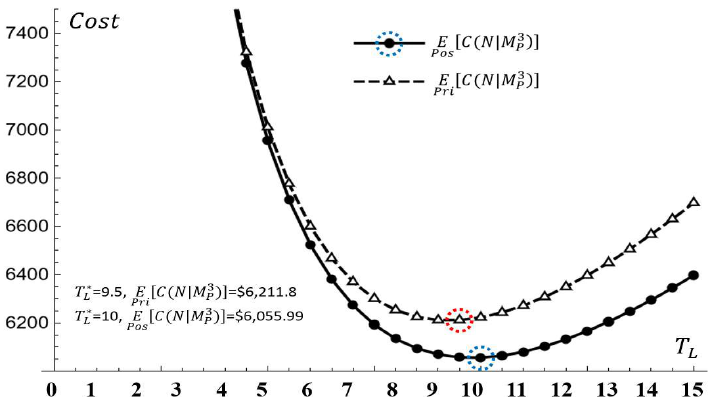
Figure 7. The overall costs per unit and year for all PM alternatives estimated by the prior and posterior analyses.